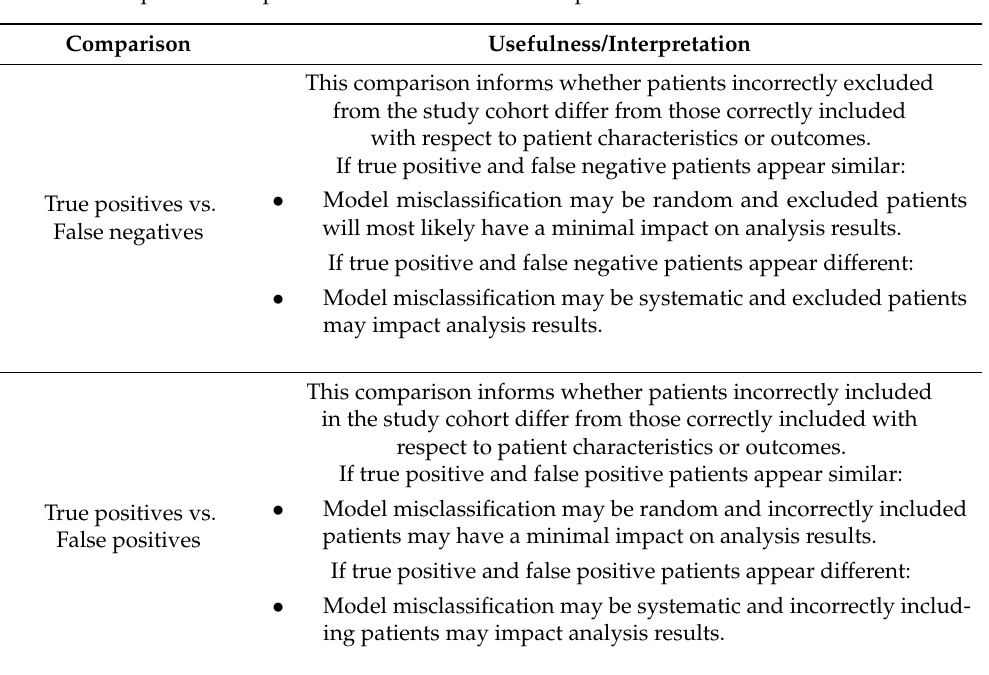
Table 3. Examples for comparison of errors and their